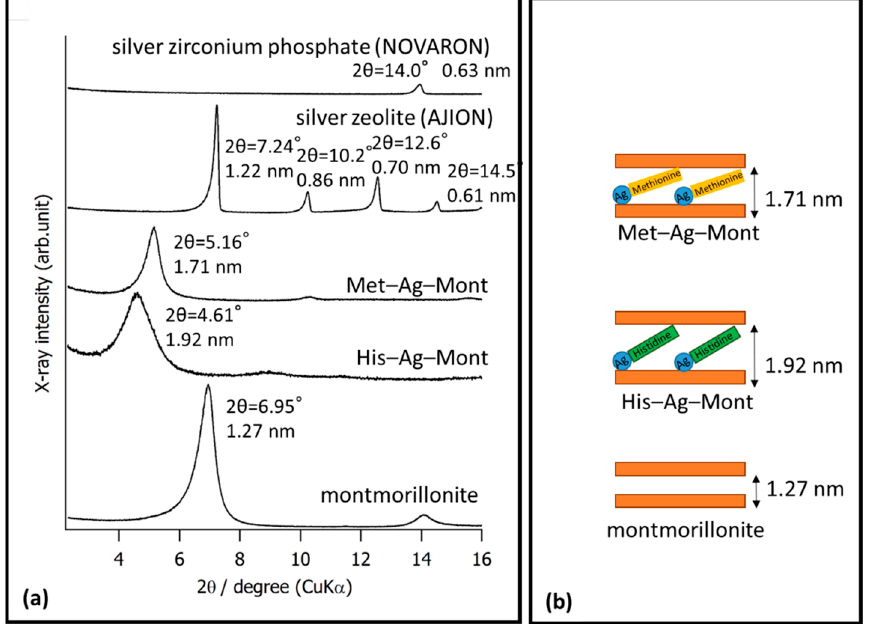
Figure 3. ( a ) XRD analysis of montmorillonite, His–Ag–Mont, Met–Ag–Mont, silver zeolite (AJION), and silver zirconium phosphate (NOVARON). ( b ) Schematic diagram of montmorillonite, His–Ag–Mont, Met–Ag–Mont.